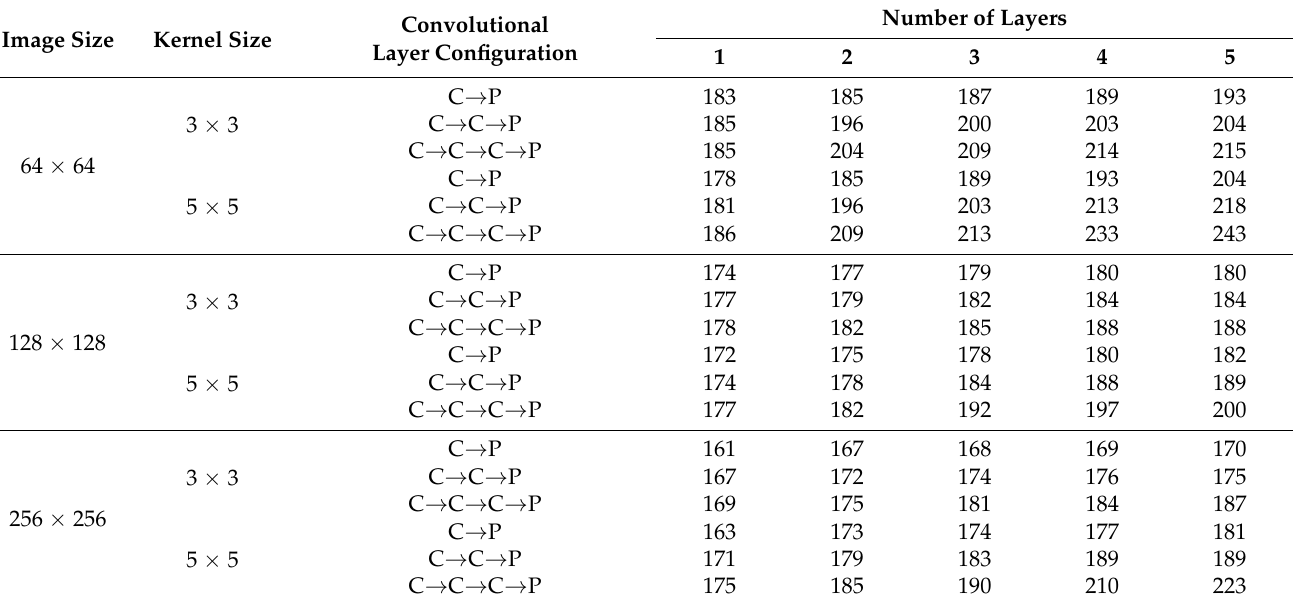
Table 4. Analysis of training time in deep learning model with hyperparameter combinations (unit: